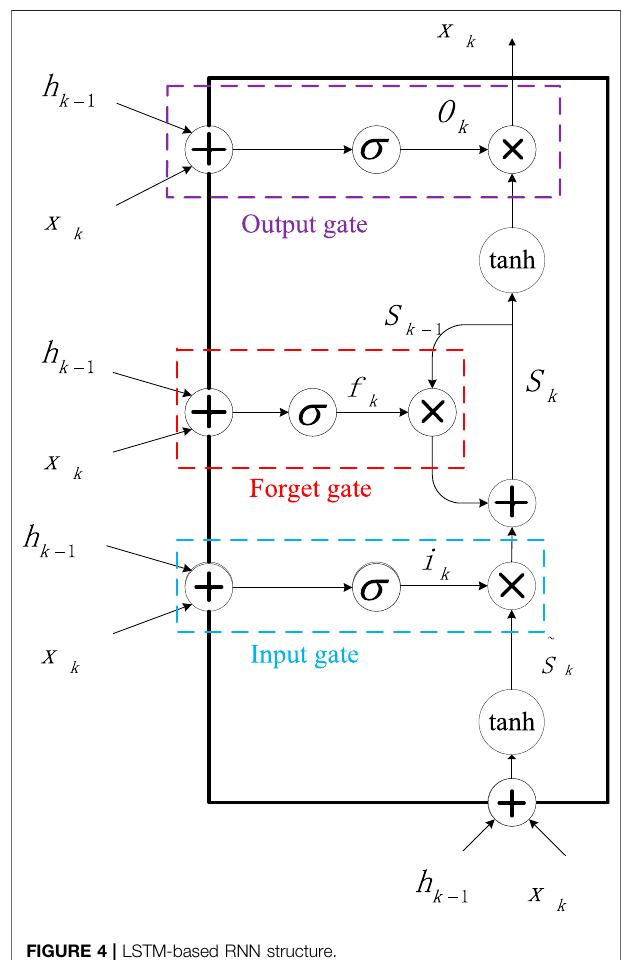
FIGURE 4 | LSTM-based RNN